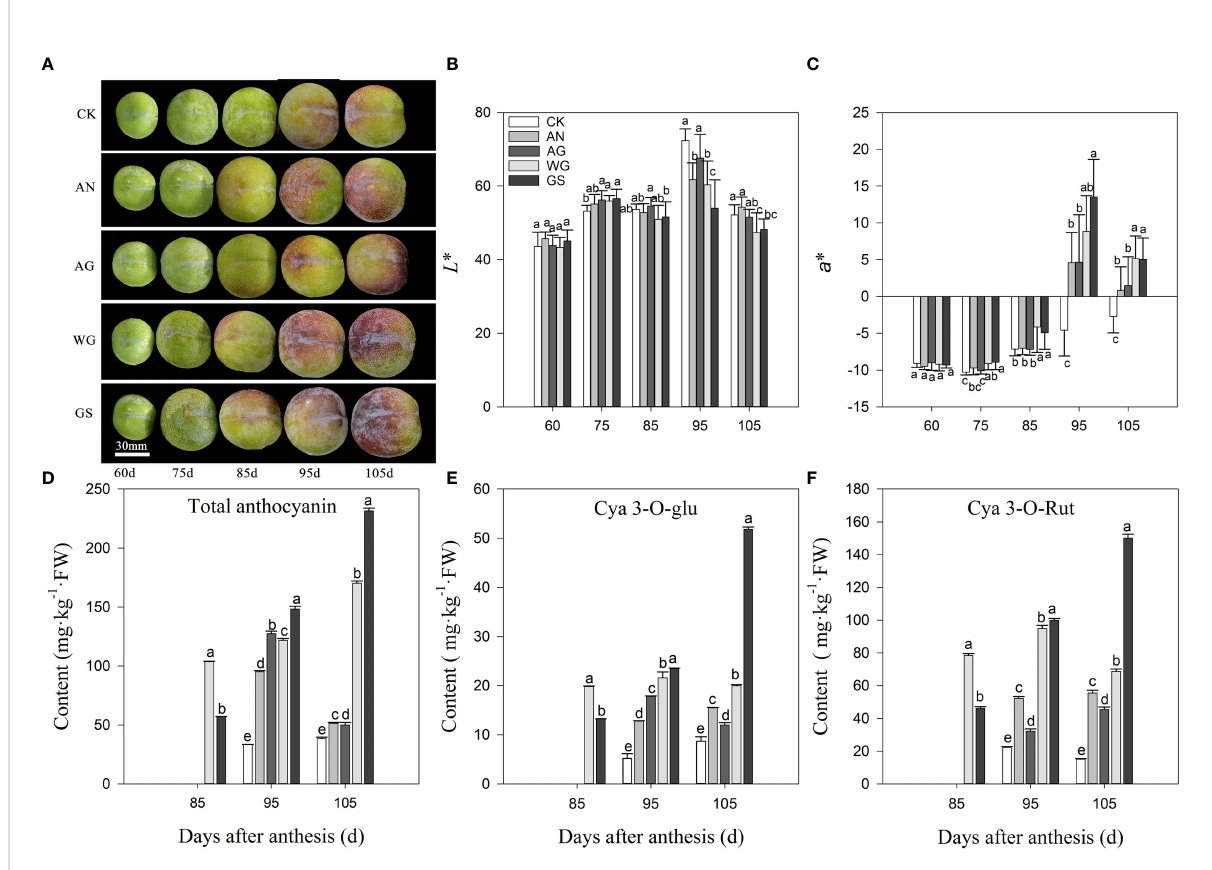
FIGURE 1 Effect of biostimulants on skin color (A) , L * value (B) , a * value (C) , total anthocyanin content (D) , and contents of anthocyanin components (E, F) . Values are mean ± SD. (n =3). Different letters indicate signi fi cantly different values at p <